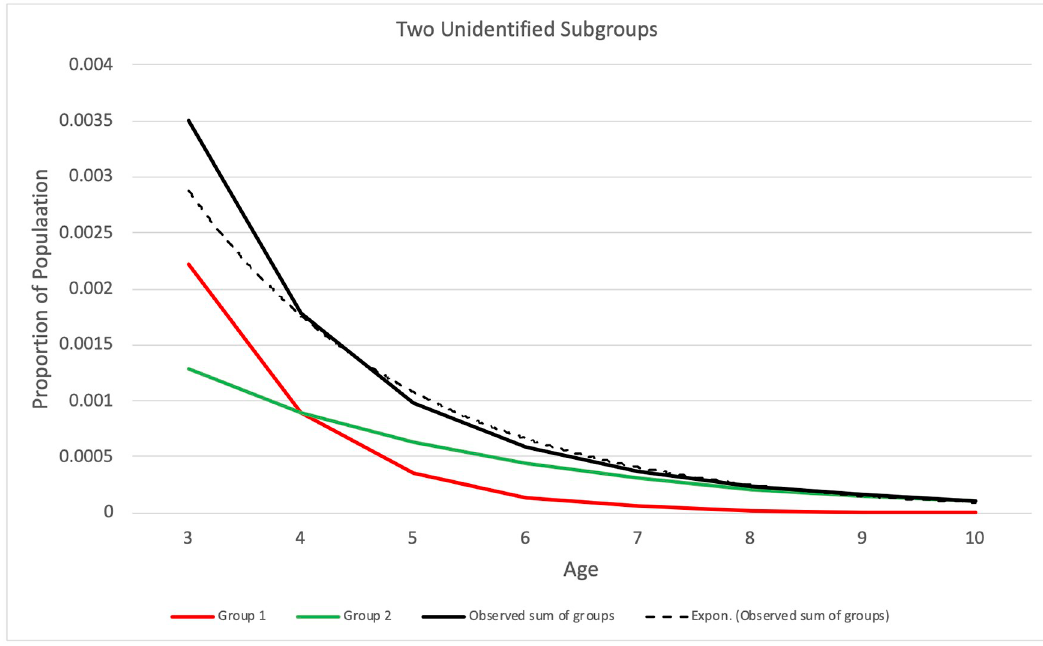
Fig 3. Example where observed diagnosis rates represent two unidentified subgroups with different values of probability of diagnosis PD . The red and green lines represent rates of diagnosis of the two subgroups. Group 1 (red line) has greater PD than group 2 (green line). The solid black line shows the aggregate diagnosis rates. The dotted line shows the exponential fit to the aggregate diagnosis rates. The age of complete eligibility AE = 3 in this